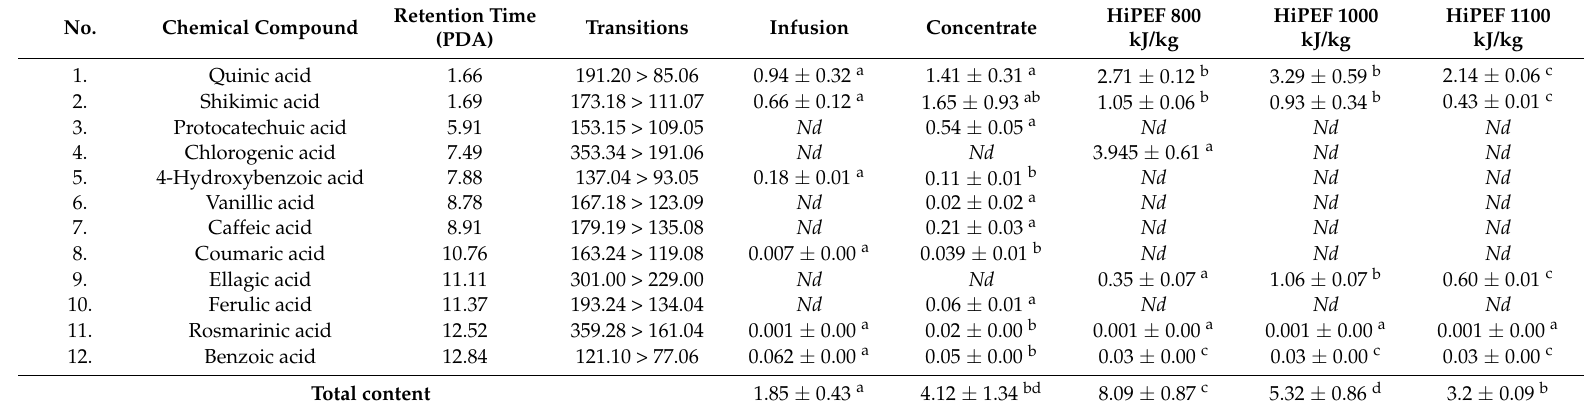
Table 3. Phenolic acid profile on beverages from Buddleja scordioides under several HiPEF-processing conditions ( µ g/mg lyophilized beverage).